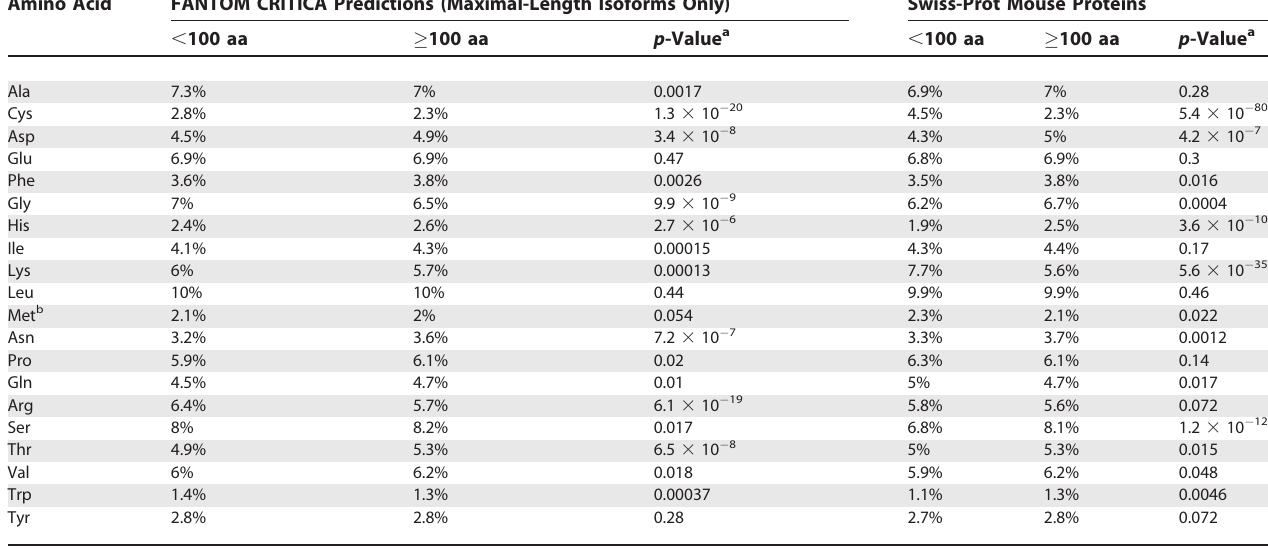
Table 6. Amino Acid Composition of Short and Long Proteins Amino Acid FANTOM CRITICA Predictions (Maximal-Length Isoforms Only)